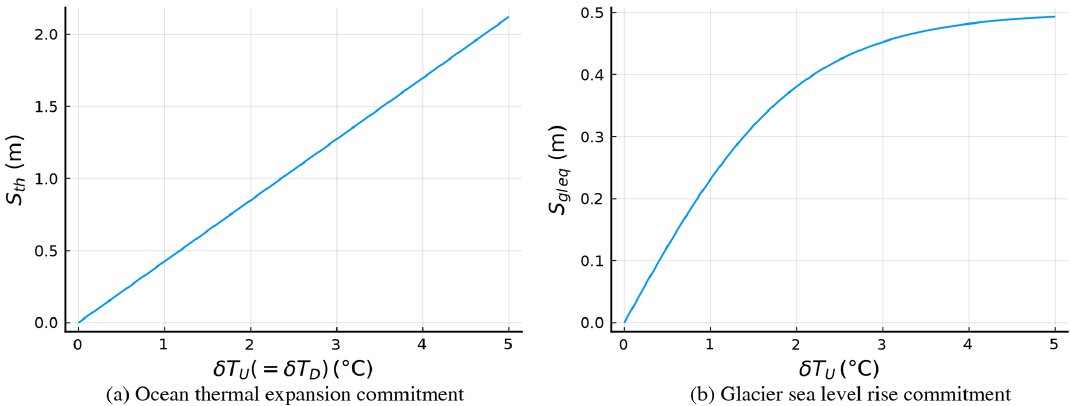
Figure 3. Equilibrium sea level rise contribution from ocean thermal expansion and glaciers.